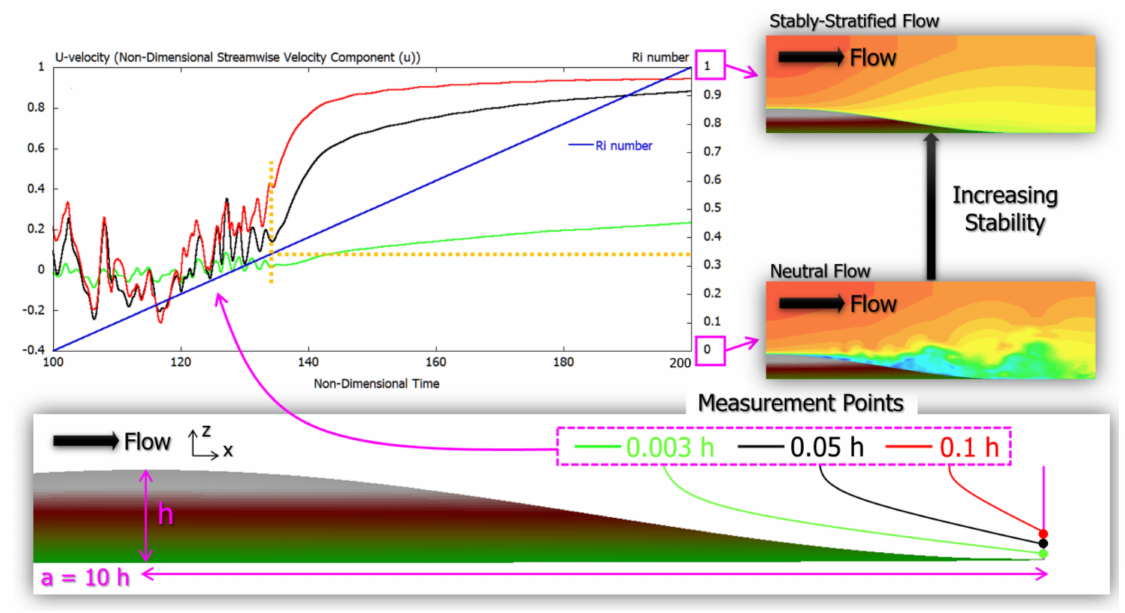
Figure 19. Time variation of U-velocity at three measurement points downstream of the gentle